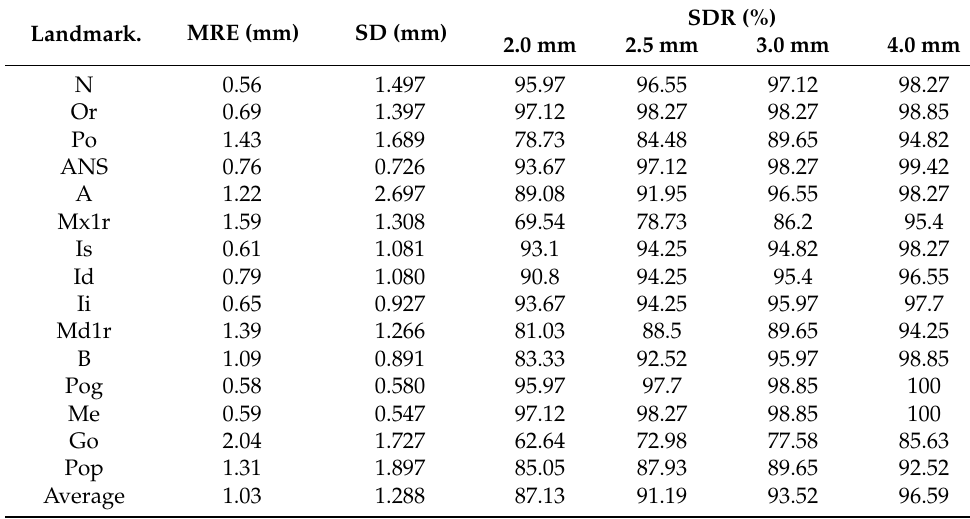
Table 2. System prediction results of 15 landmark identification in combination data.